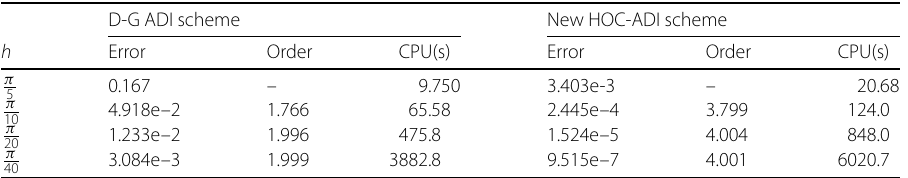
Table 1 Numerical comparison results of the D-G ADI scheme and the new HOC-ADI scheme for Example 1, at T = 2, time step τ = 0.001